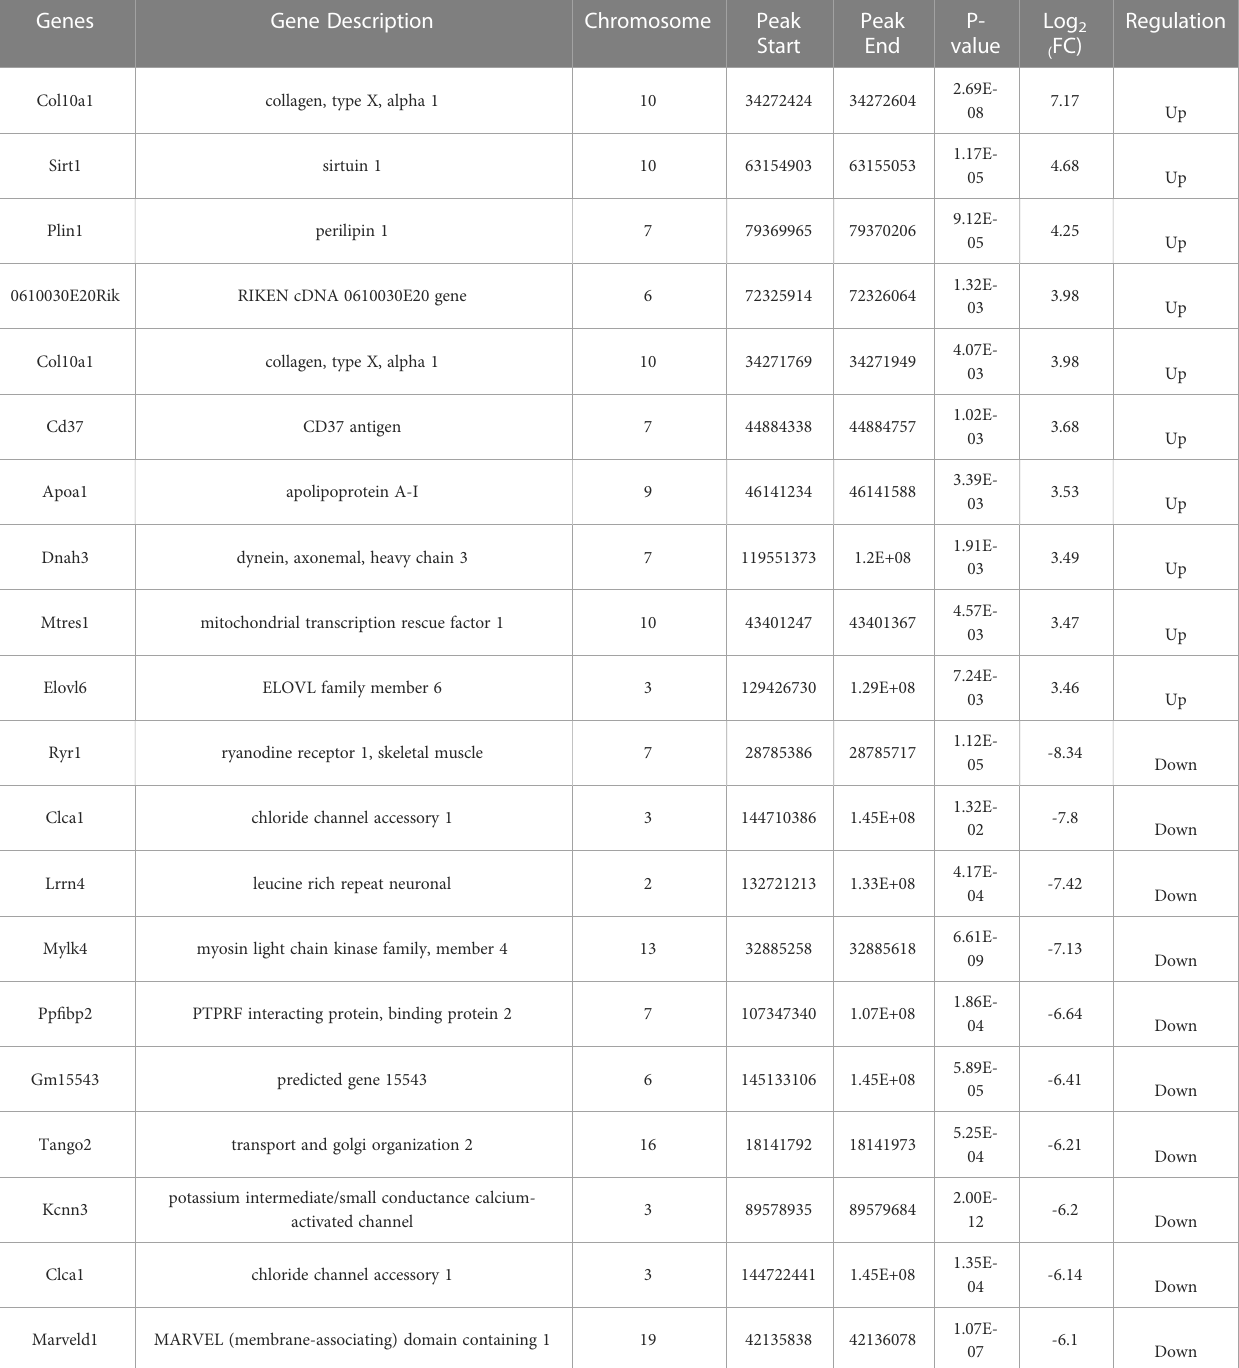
TABLE 2 Top 10 differentially expressed mRNAs between stable COPD and control group based on log 2 (FC) value.